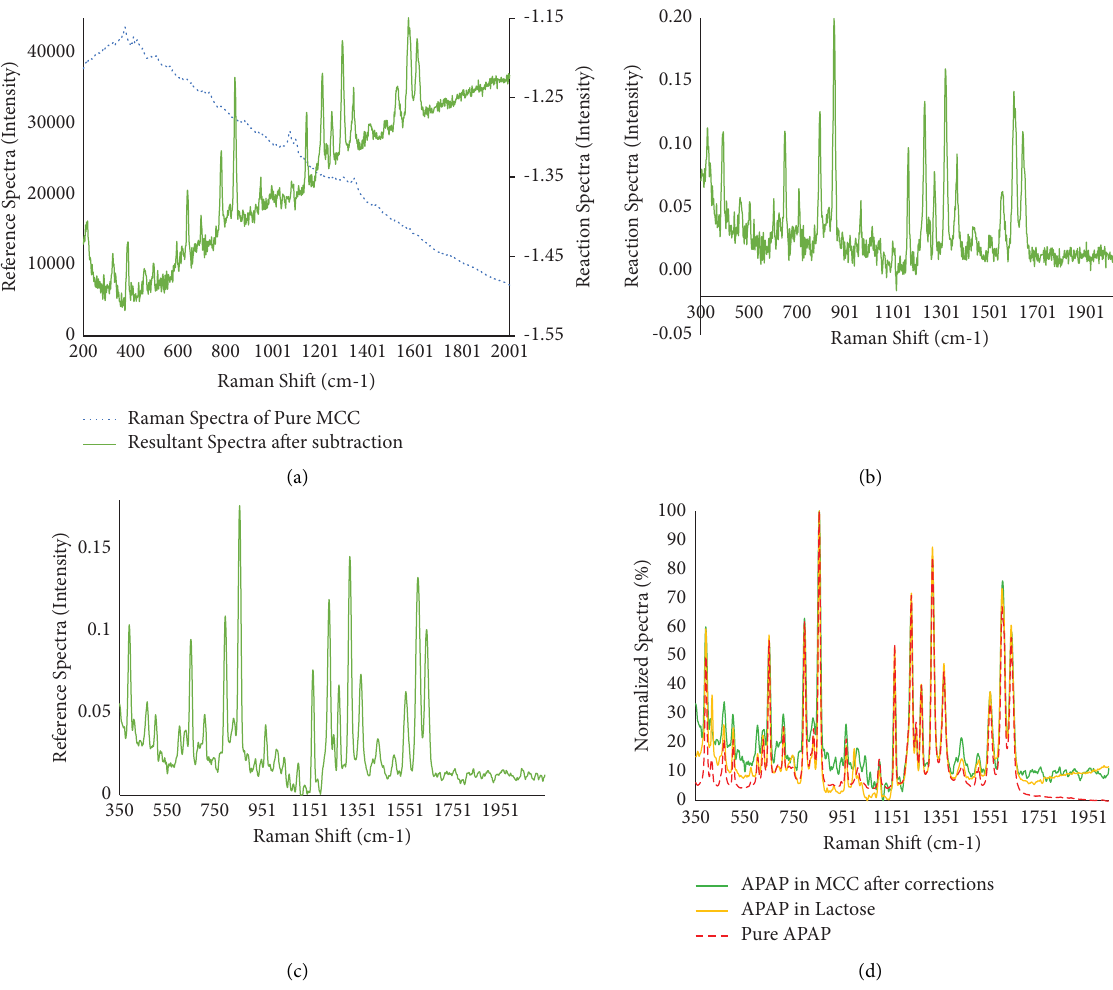
Figure 5: (a) Raman spectra of pure MCC (blue) and resultant spectra after fuorescent material spectra subtraction, (b) Raman spectra after baseline correction, (c) Raman spectra after smoothing, and (d) Raman spectra of 10% APAP in MCC after corrections (green), 10% APAP in lactose (yellow), and pure APAP